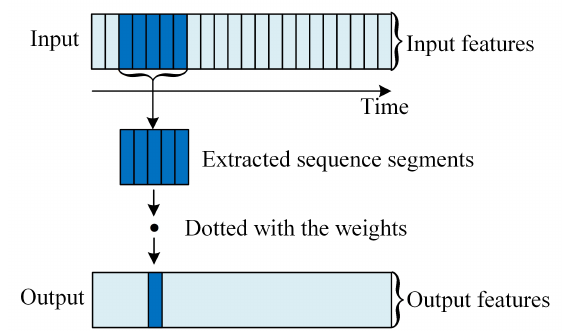
Figure 5. The working principle of 1D CNN. Each output time step is obtained using a small segment of the input sequence in the time